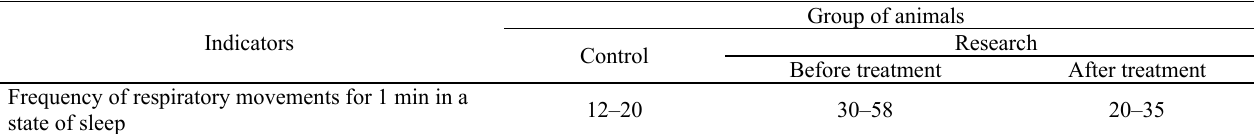
Group of animals Research Control Before treatment After treatment